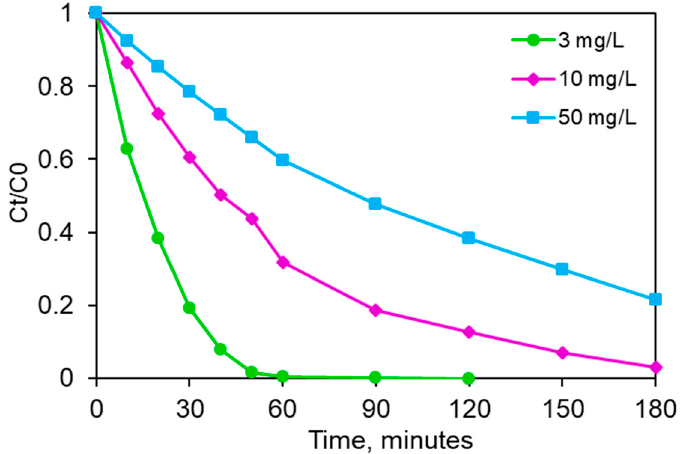
Figure 12. E ff ect of the initial clofibric concentration on the photocatalytic degradation e ffi ciency Figure 12. Effect of the initial clofibric concentration on the photocatalytic degradation efficiency (Zn4La400 500 mg / L; stirring rate 450 rpm, natural pH, UV-A (Zn4La400 500 mg/L; stirring rate 450 rpm, natural pH, UV-A irradiation).